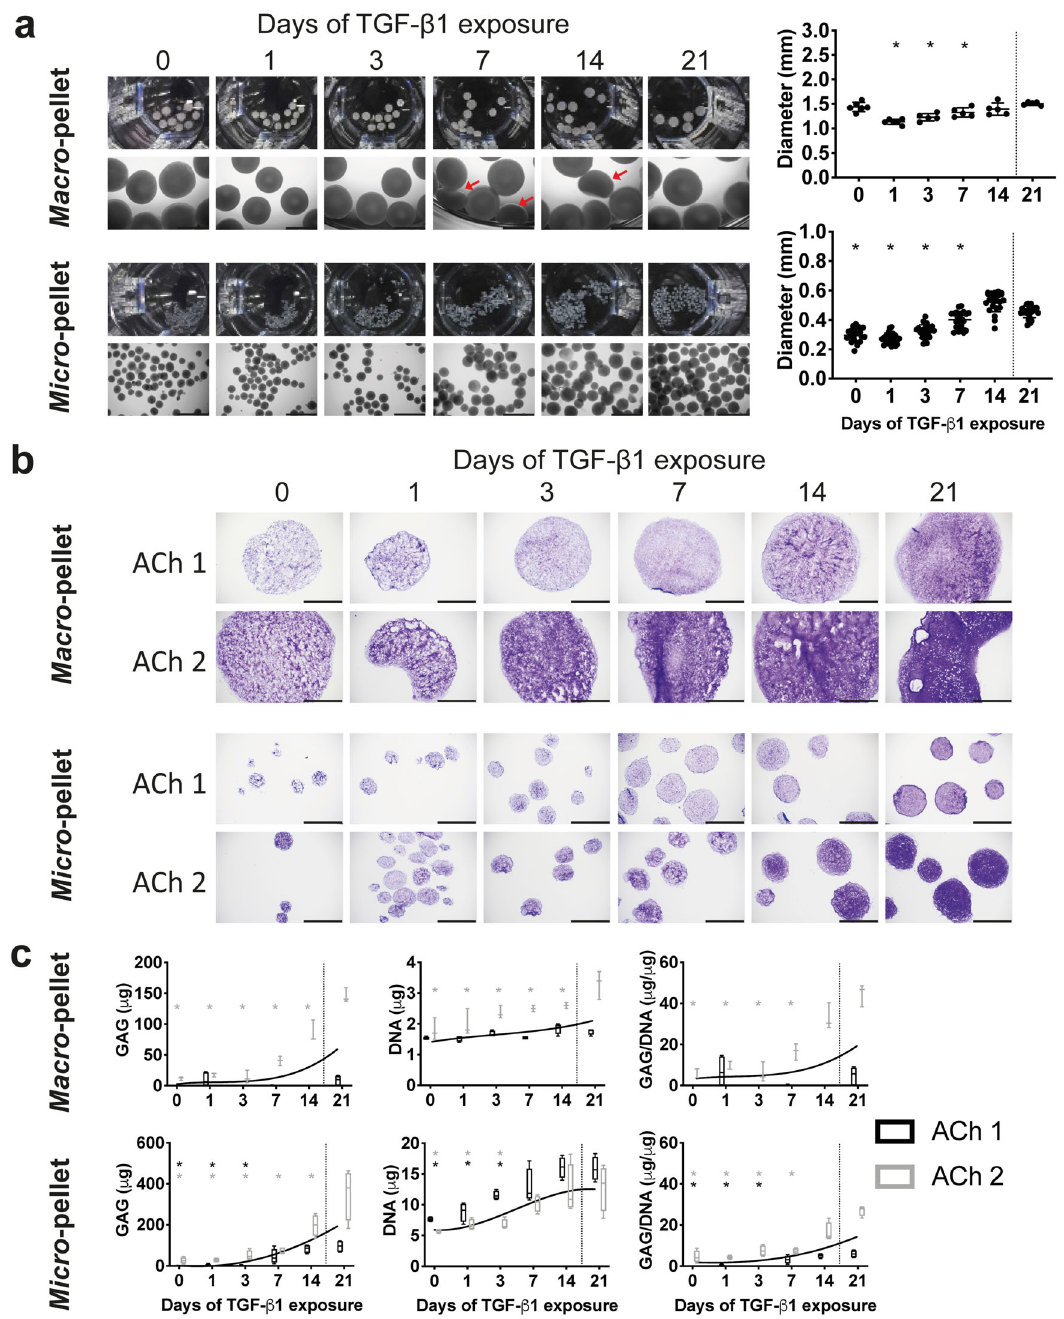
Fig. 3 Cartilage-like tissues derived from ACh after 21 days in vitro differentiation with TGF- β 1 exposure for the number of days indicated. a Gross photographs and bright fi eld microscopy images of whole ACh-derived tissues (scale bars for microscopy images, 1 mm), and corresponding diameters. b Toluidine blue stain of macro - and micro -pellet tissue cross-sections are shown for two unique ACh donors (scale bars, 500 μ m). c GAG, DNA, and normalized GAG/DNA quanti fi cation for ACh donors. Asterisks are shown for values that are signi fi cantly lower than the corresponding 21 days of TGF- β 1 exposure control. Box plots: n = 4 for each donor; * P <